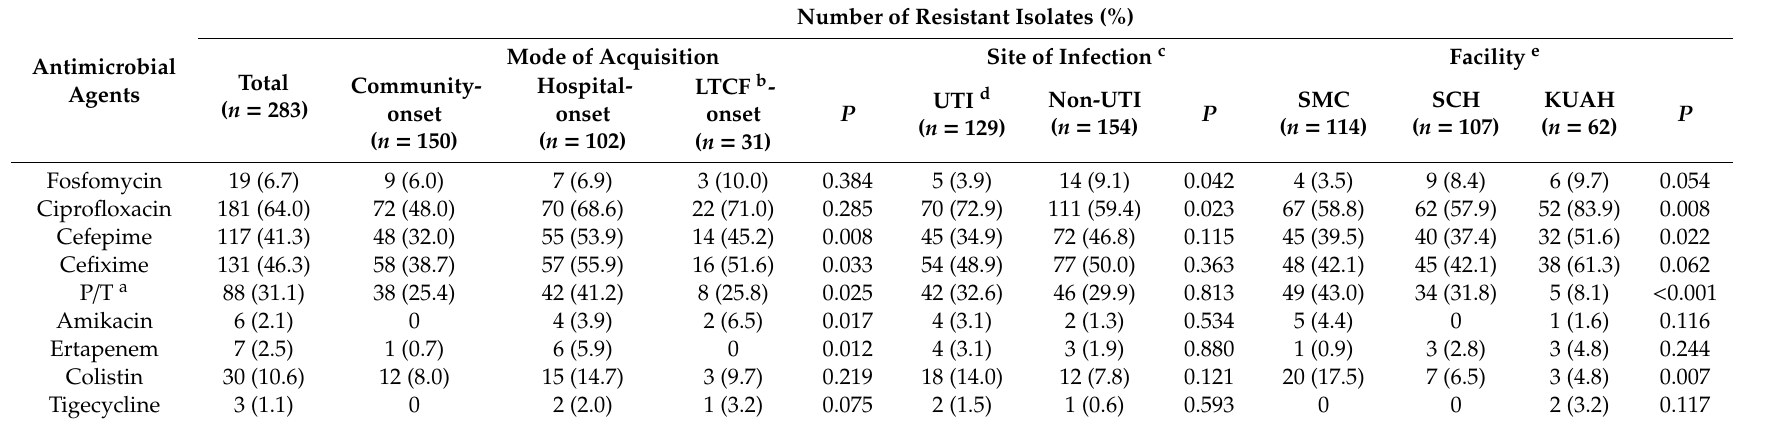
Table 1. Antibiotics susceptibilities of all E. coli isolates in this